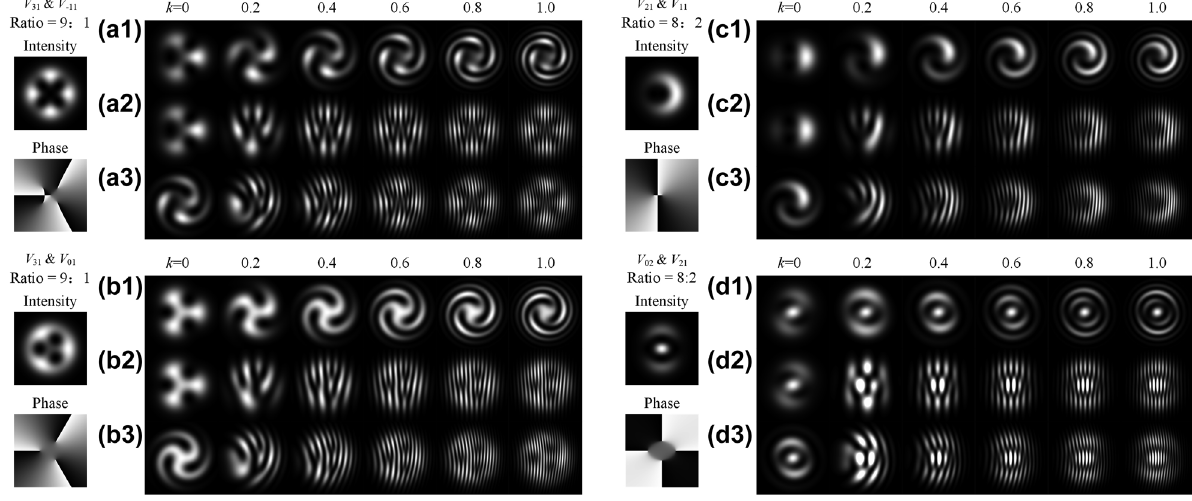
Figure 5: Interferencepatterns of structured lights consisting of (a) V 31 and V − 11 with intensity ratio 9:1, (b) V 31 and V 01 with intensity ratio 9:1, (c) V 21 and V 11 withintensityratio8:2,and(d) V 02 and V 21 withintensityratio8:2,when fi xing((a1),(b1),(c1)and(d1)) k x = 0,((a2),(b2),(c2)and (d2)) k r = 0, ((a3), (b3), (c3) and (d3)) k r = 0 . 4 and scanning the other k from 0 to